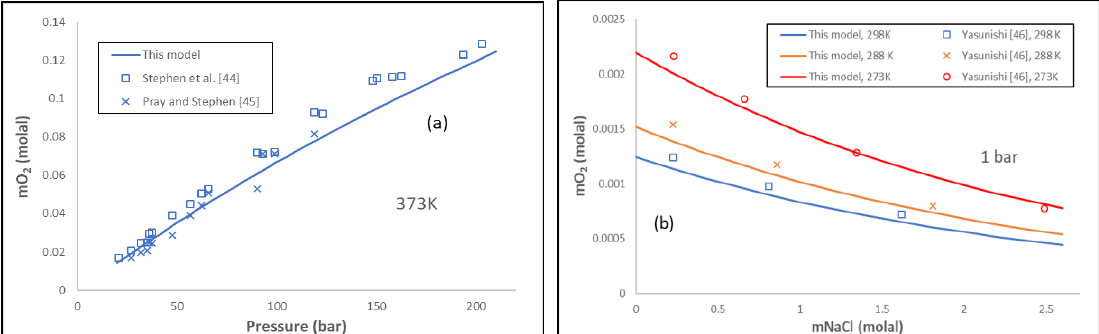
Figure 3. O 2 -brine mutual solubility obtained from experimental data [44–46] (dots) and the results calculated by the model (lines) at various values of temperature, pressure and salinity. ( a ) O 2 solubility in water. ( b ) O 2 solubility in NaCl solutions.